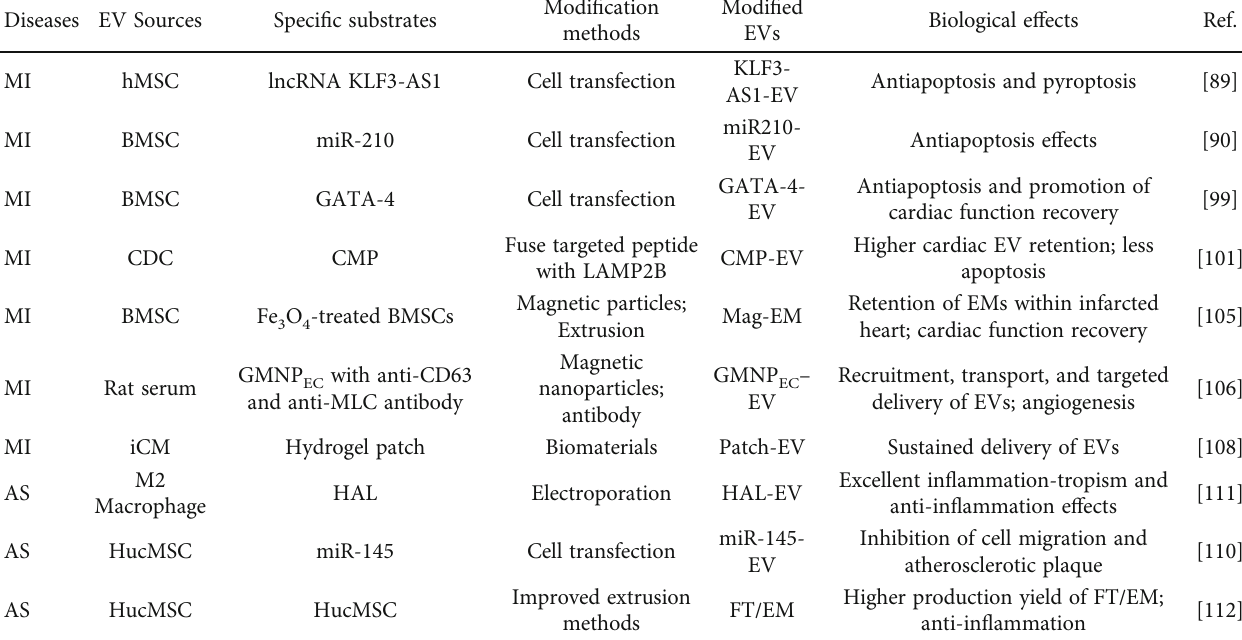
Table 4: Modi fi ed EVs in the therapy of cardiovascular related